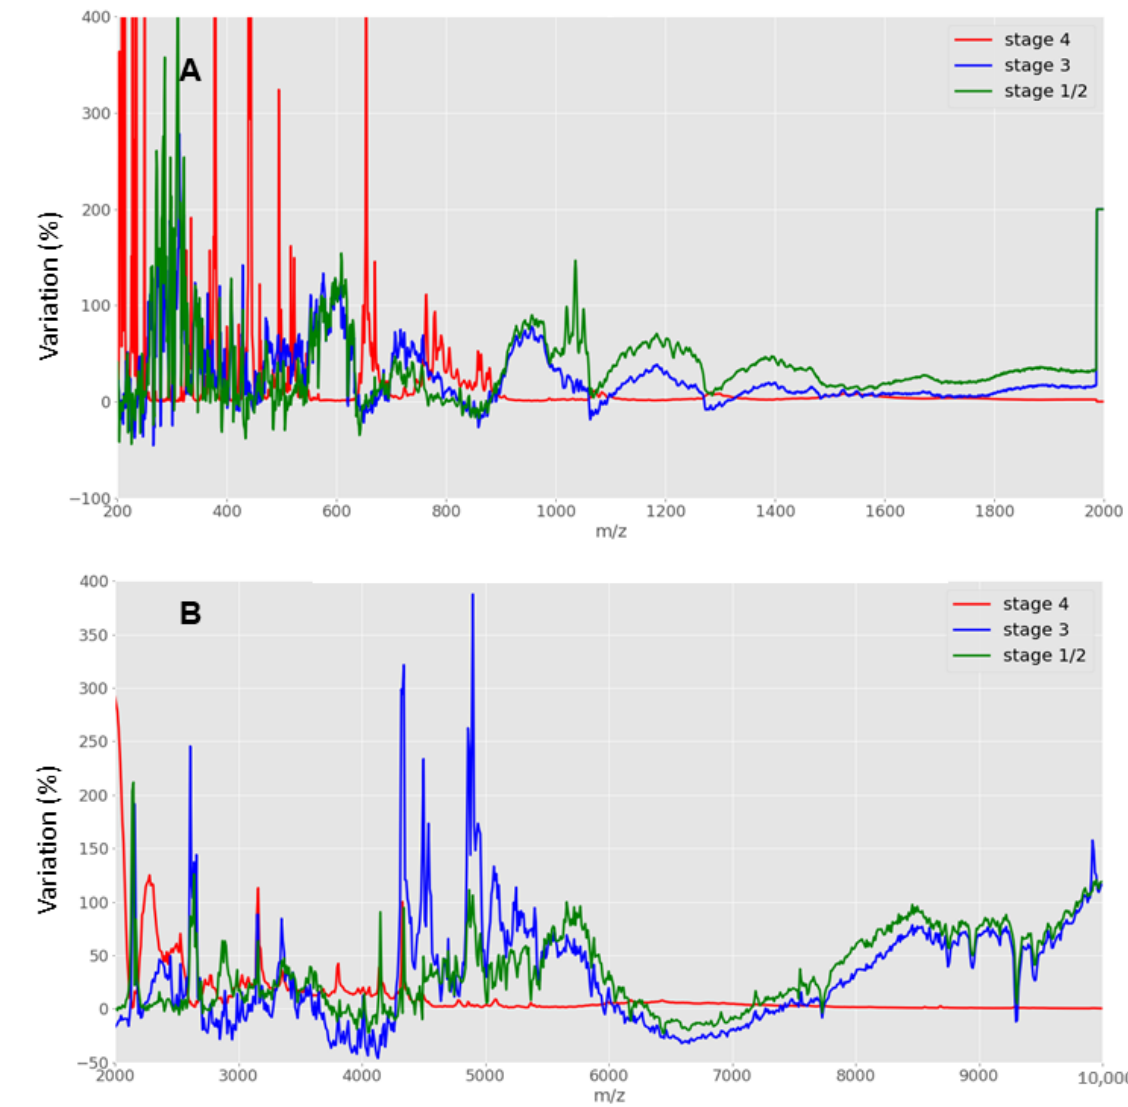
Figure 2. Averaged variation across the mass spectrum of women with ovarian cancer in comparison with the control group. ( A ) Variation calculated for CHCA-matrix-generated data. ( B ) Variation calculated for SA-matrix-generated data. Red indicates variations in women with ovarian cancer at stage 4, blue at stage 3, and green at early stages (stage 1 or 2). Variations were calculated by the difference between the averaged mass spectrum of a particular stage and the control (not having cancer), expressed in percentage of the control.